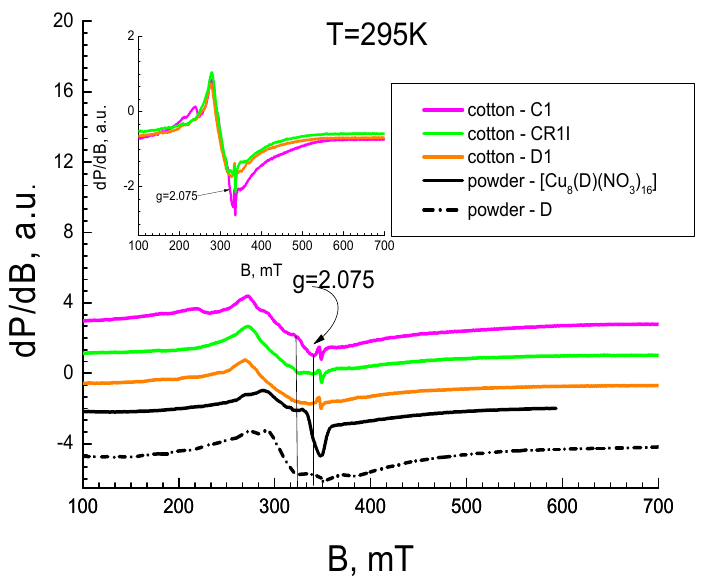
Figure 3. EPR spectra of cotton fabrics at 295 K: D1 (orange line), C1 (magenta line), CR1I (green line). EPR spectra of the dendrimers in powder: dendrimer (black dash-dot line), dendrimer complex (black solid line). Inset: overlaid spectra of the fabric samples.